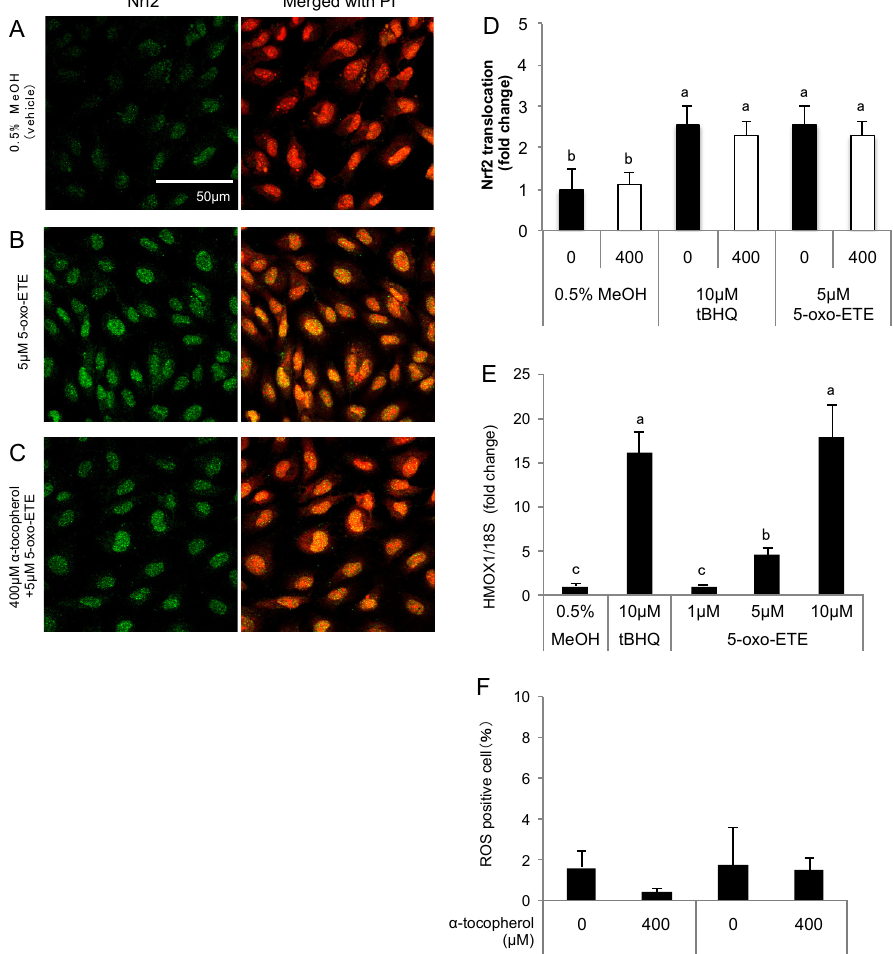
Figure 5. Effects of 5-oxo-ETE on Nrf2 activation in HUVECs. Nuclear translocation of Nrf2 was detected by immunostaining. The cells were treated for 3 h with: 0.5% MeOH (vehicle control) ( A ); and 5 µ M 5-oxo-ETE ( B ); and the pretreatment with 400 µ M α -tocopherol for 1 h was performed before treatment of 5-oxo-ETE ( C ). The intensity of the green fluorescence signal in the nucleus was quantified using Image J ( D ); Data are expressed as the mean ± SD ( n = 8) Significant differences among the groups are indicated with different letters (one-way ANOVA followed by a post hoc Tukey’s test, p < 0.05). Gene expression of HMOX1 in the cells treated with 1, 5, and 10 µ M 5-oxo-ETE for 6 h was analyzed ( E ). Data are expressed as mean ± SD ( n = 3). Significant differences among the groups are indicated with different letters (one-way ANOVA followed by a post hoc Tukey’s test, p < 0.05). ROS generation in HUVECs was detected by CellROX Green ( F ). HUVECs were treated with 400 µ M α -tocopherol for 1 h, and subsequently the cells were incubated for 1 h after the addition of 5 µ M 5-oxo-ETE. Data are expressed as the mean ± SD ( n =